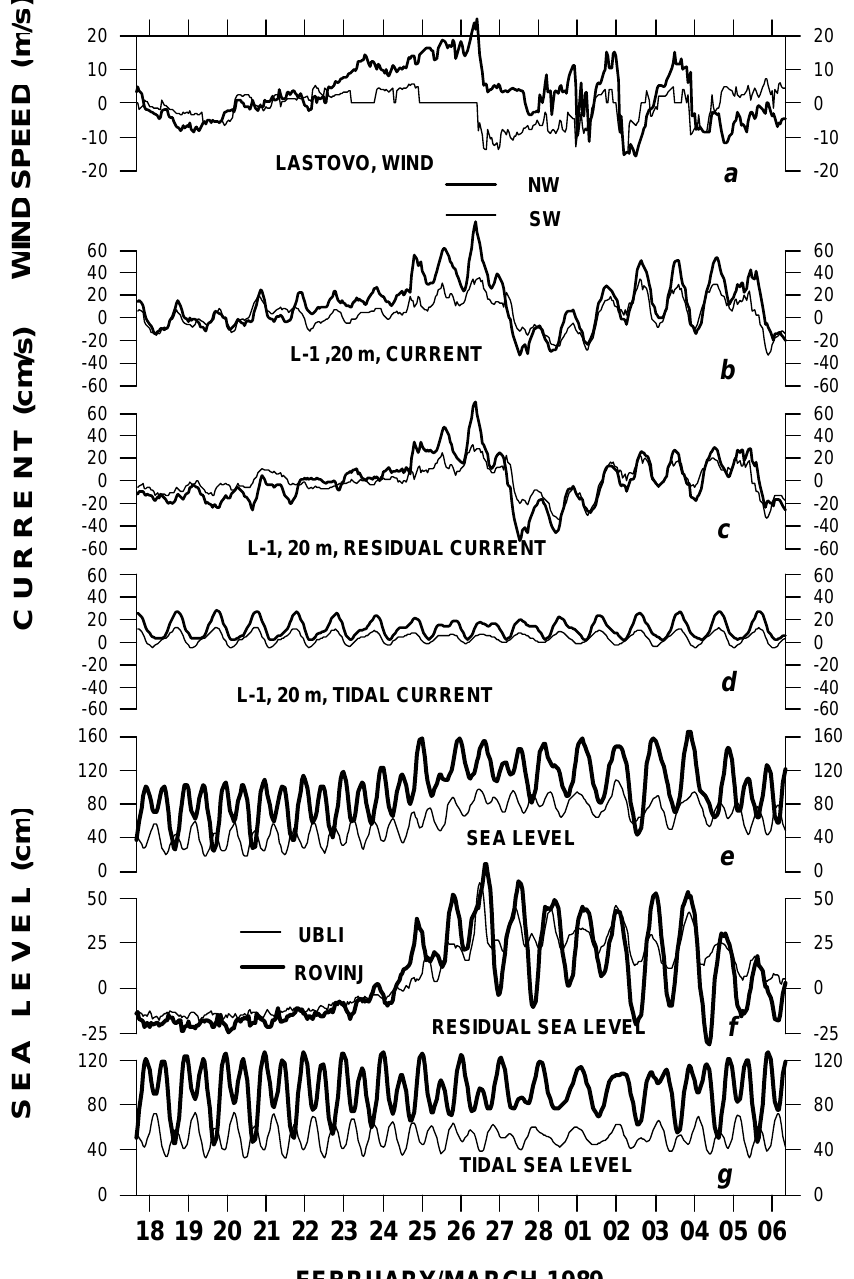
Fig. 4. Time series of hourly NW and SW components of wind at Lastovo (a) and of measured currents (b) , residual currents (c) and tidal currents at L-1 (nominal depth of 20m) (d) , measured sea level (e) , residual sea level (f) and tidal sea level at Rovinj and Ubli (g)